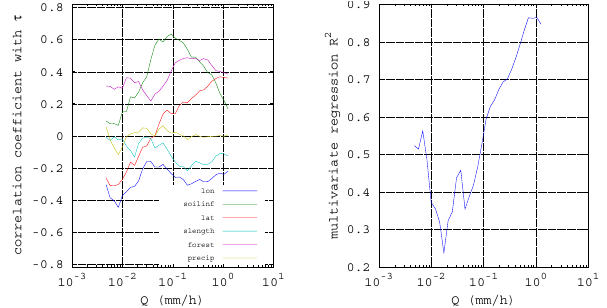
Fig. 7. (a) Nonparametric (Spearman) correlation coefficient with the recession timescale at different streamflows of the six variables (1) longitude, (2) soil infiltration capacity, (3) latitude, (4) channel length, (5) forest cover, (6) precipitation; | r | ≥ 0 . 3 is significantly different from zero at the 0.05 level. (b) Coefficient of determina- tion R 2 for multivariate linear regression with these six predictor variables; R 2 ≥ 0 . 3 is significant at the 0.05